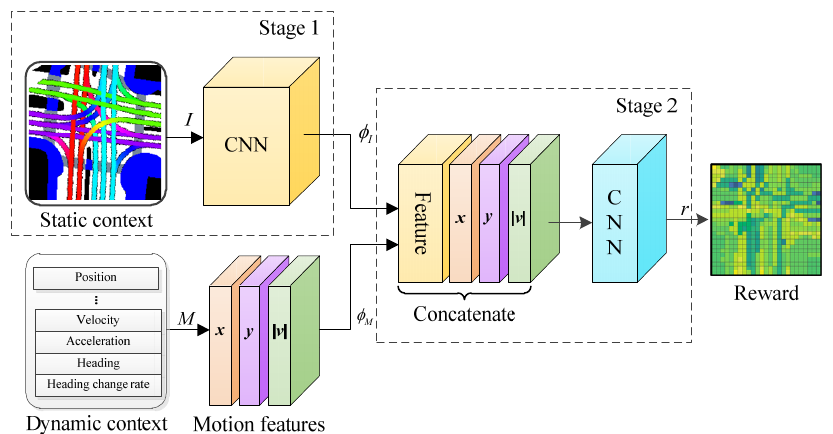
Figure 2. Reward initialization based on two-stage backbone. The scene feature I has the same dimensions as the 2D grid, matching to state